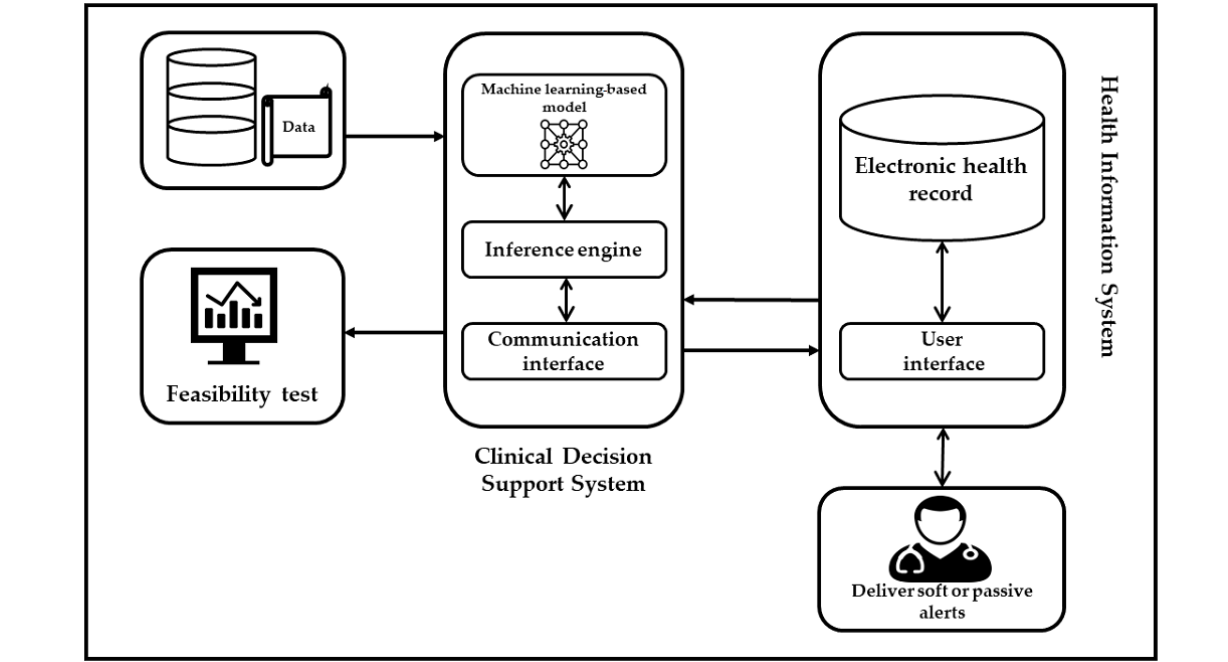
Figure 5. Future direction of this